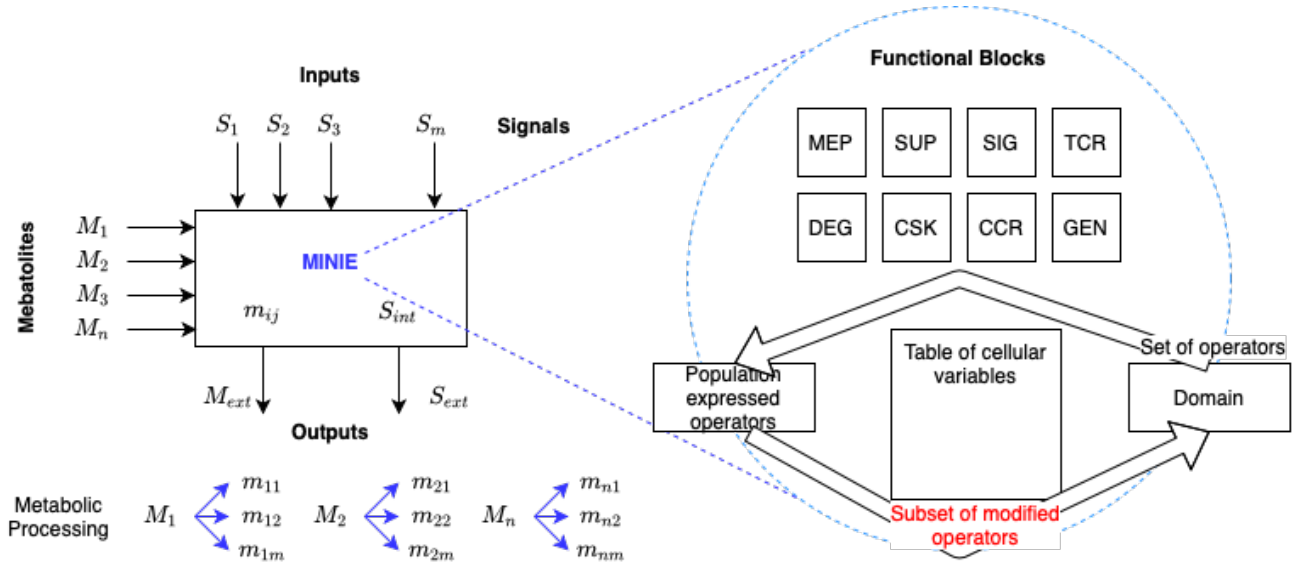
Figure 1. MECOMP.NET diagram: it receives metabolic ( M ) and signaling inputs ( S ), processes them ( m 1 , m 12 , · · · , S int ) in a single cell unit represented as (MINIE), generating metabolic ( M ext ) and signaling outputs ( S ext )